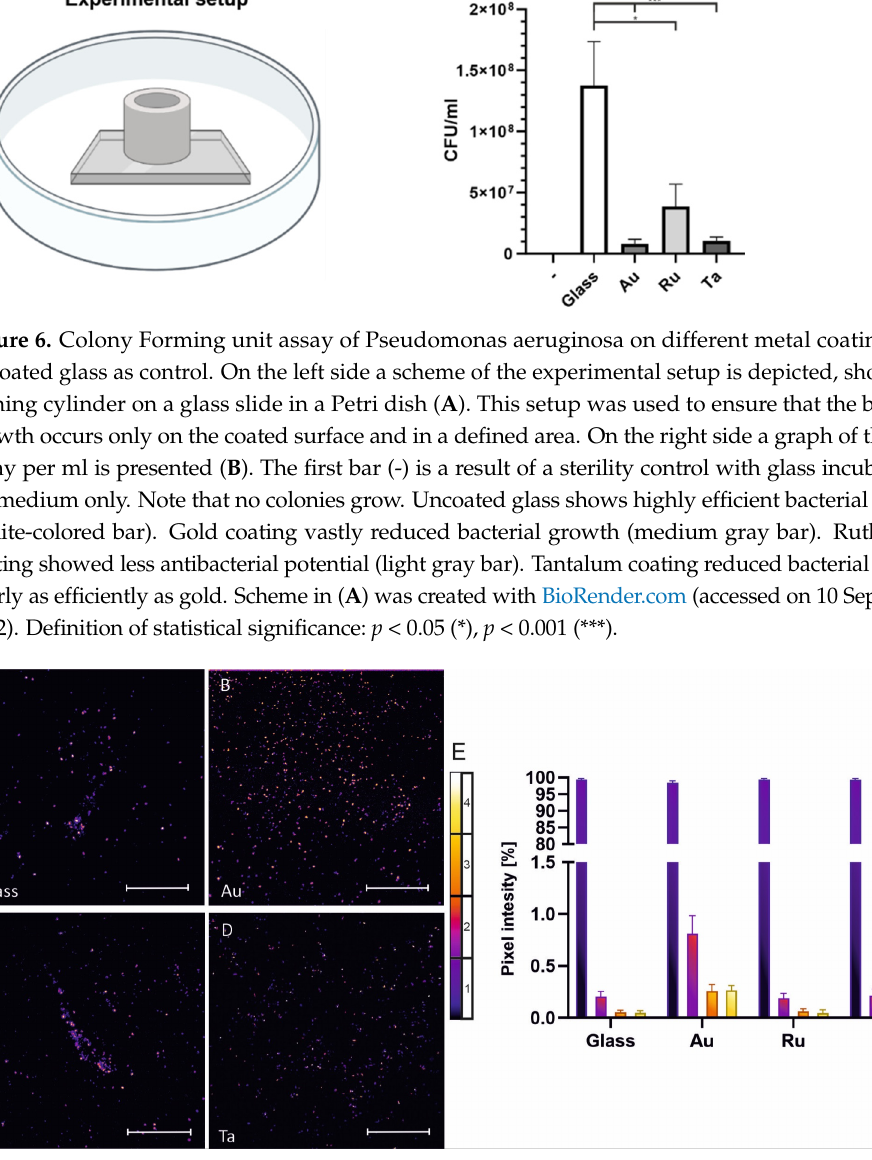
Figure 7. ROS assay of Pseudomonas aeruginosa grown for 24 h on glass, gold, ruthenium and tan- talum surfaces. Reactive oxygen species were measured with the help of 2-7-dichlorofluorescin di- acetate assay. Images were obtained by confocal laser scanning microscopy and are presented as false color images, using a fire ice false color coding ( A – D ). Highest intensity is depicted as yellow white and darkest pixels are shown as black blue. Most pixel values are in the background range